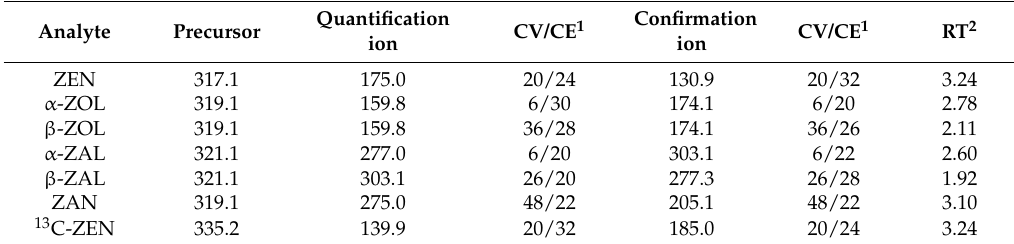
Table 1. MS/MS transitions of ZEN and its